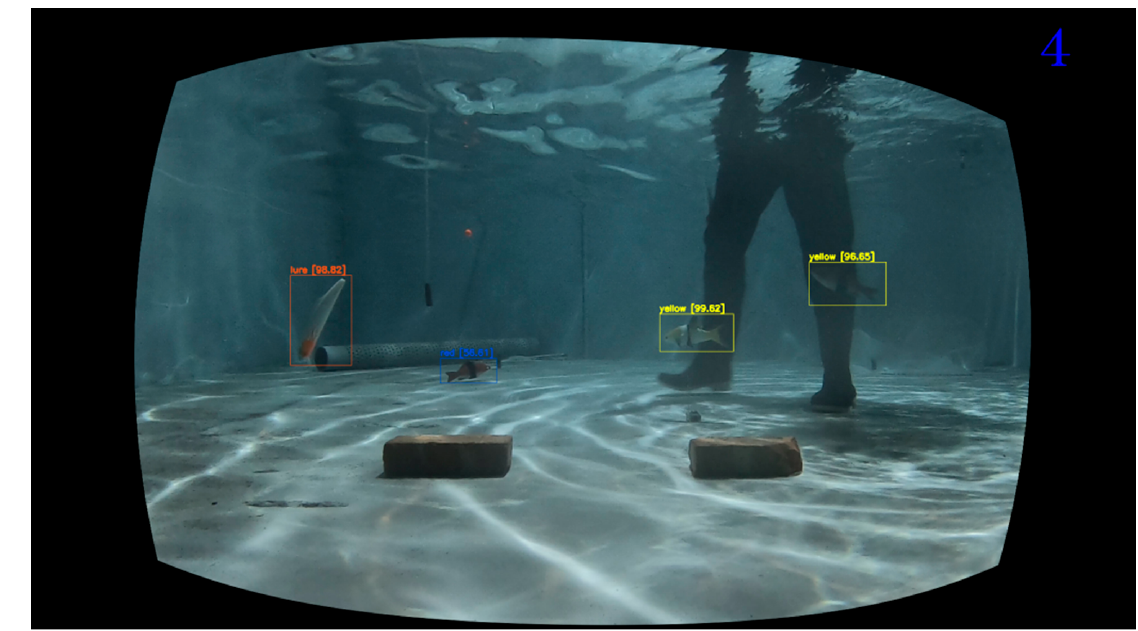
Figure 27. Fish target object detection results using YOLOv4 using the fake fish experiment.